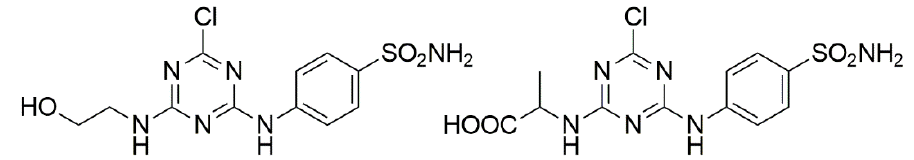
Figure 1. Example of a carbonic anhydrase inhibitors structure. [10].